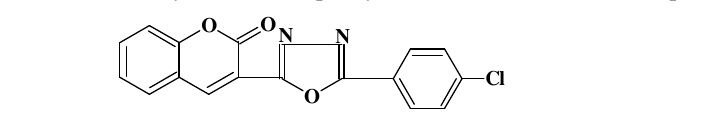
Figure 3. 2-(Chromen-3'-onyl)-5-(4"-nitrophenyl)-1,3,4 -oxadiazole (L3); m.p. 203º